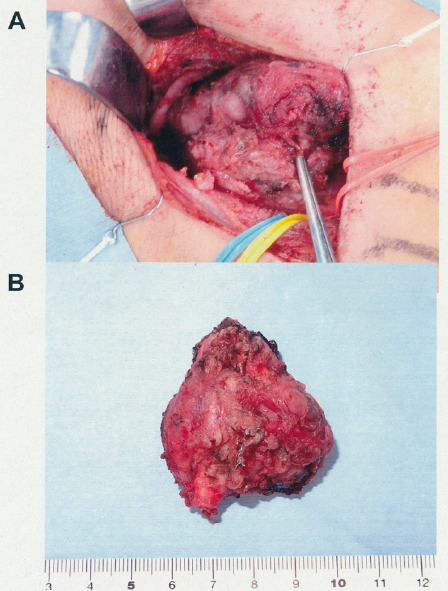
Figure 2. Operative view and resected specimen. ( A ) Operative view of carotid body tumor (CBT) surgical resection. The tumor covers the internal and external carotid arteries, which are not visible. The common carotid artery (red), vagal nerve (yellow), and internal jugular vein (blue) were secured using a vessel loop and preserved. The hypoglossal nerve that is visible was preserved. ( B ) Lateral view of the removed specimen. The carotid bifurcation, including the common carotid artery, internal carotid artery, and external carotid artery, were resected along with the tumor. The cut lumen of the common carotid artery is visible on the lower side of the tumor.